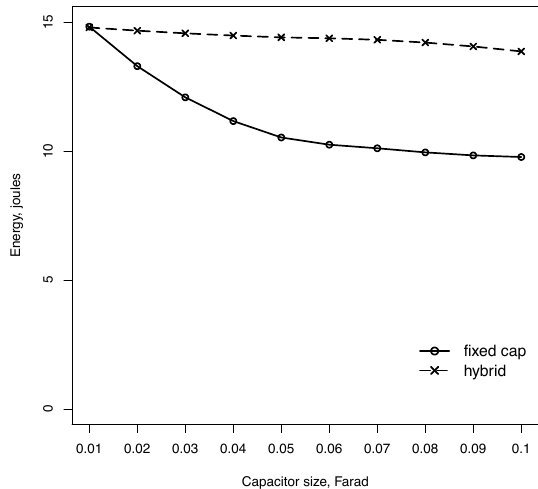
Figure 4. The amount of usable harvested energy in the fixed capacitor configuration decreases with capacitor size due to self-discharge losses between intermittent charges. The hybrid configuration minimizes the losses by using a small capacitor in low energy areas.